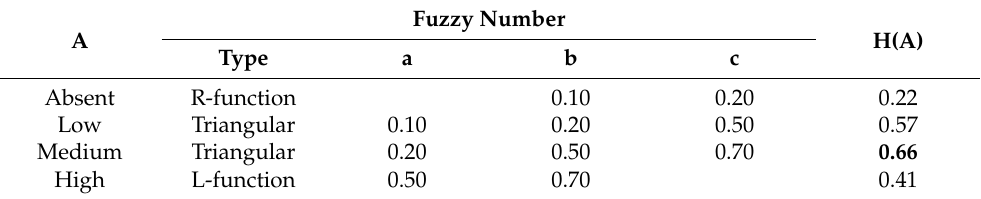
Table 6. Fuzzy sets in the fuzzy partition in Figure 12 and their fuzziness.